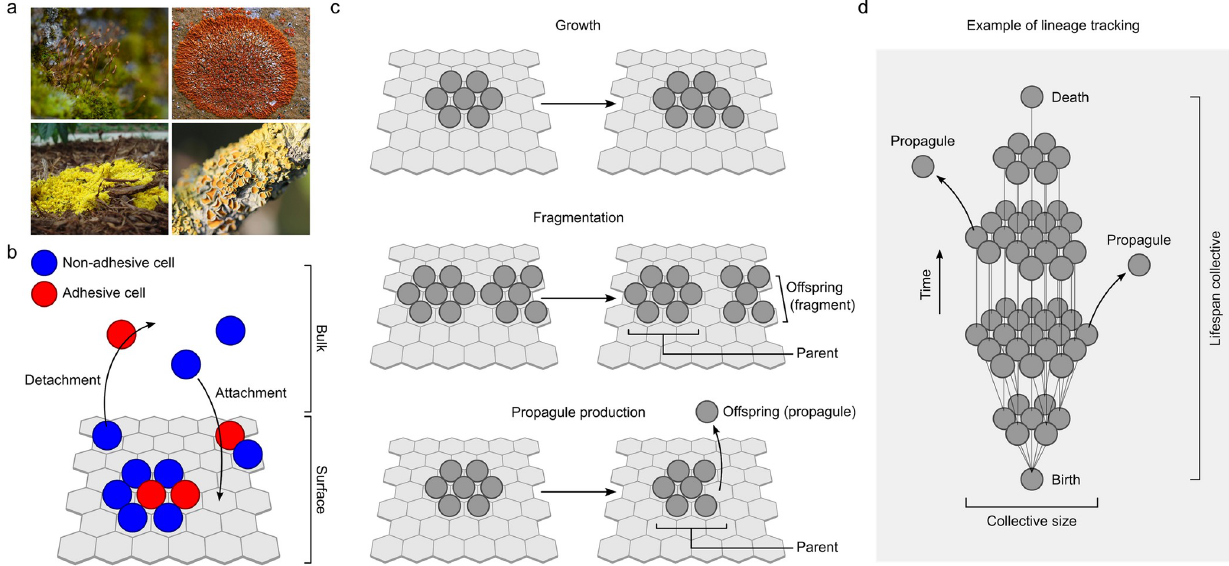
Fig 1. Surface colonization and tracking cell collectives. (a) Examples of surface-associated multicellularity, top–bottom: Bryophyta, Ascomycota, slime mold, and lichen (images are shown under the Creative Commons license from Wikimedia and Needpix; Rostislav Kralik, Jason Hollinger). (b) Schematic depiction of model adopted from [41]. Cells can occupy 2 environments: the surface and the bulk. In the bulk, cells freely move around. The surface is represented by a hexagonal grid to which cells can attach. Adhesive cells (red) can adhere to the surface independently. Nonadhesive cells (blue) can only adhere when neighboring an adhesive cell. (c) Processes of collective growth and collective reproduction. Collective reproduction can either result from fragmentation of the collective on the surface or from propagule production, where a cell detaches to the bulk. (d) Simplified depiction of lineage tracking from “birth” to “death” of a collective. Collective size is determined by the number of cells in the collective. Collective life span is determined by the number of time steps during which the collective